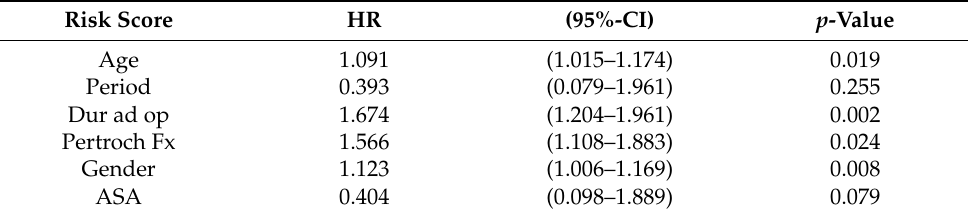
Table 3. Cox univariate regressions: overall survival is a dependent